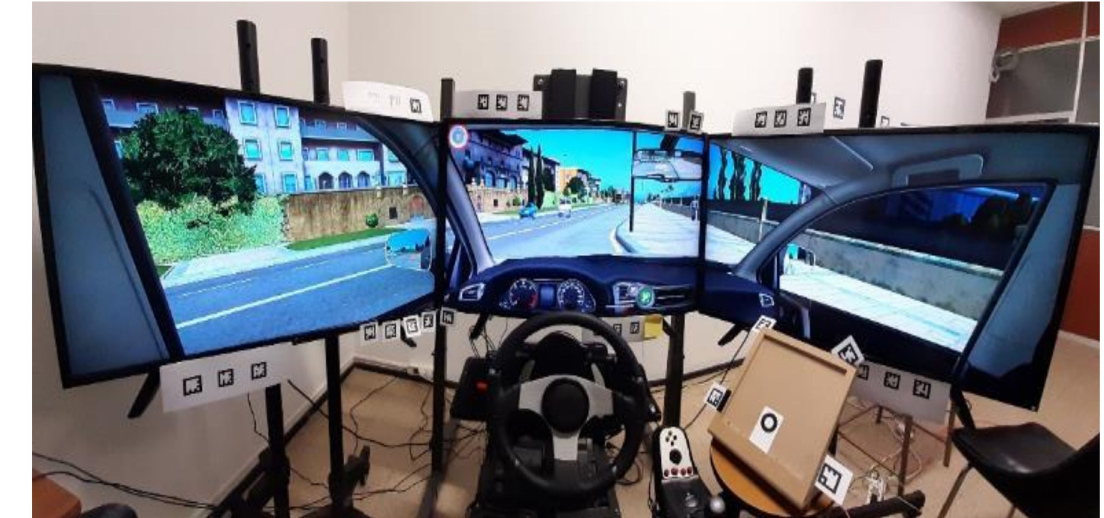
Figure 2. Simulator with three screens used in the study.